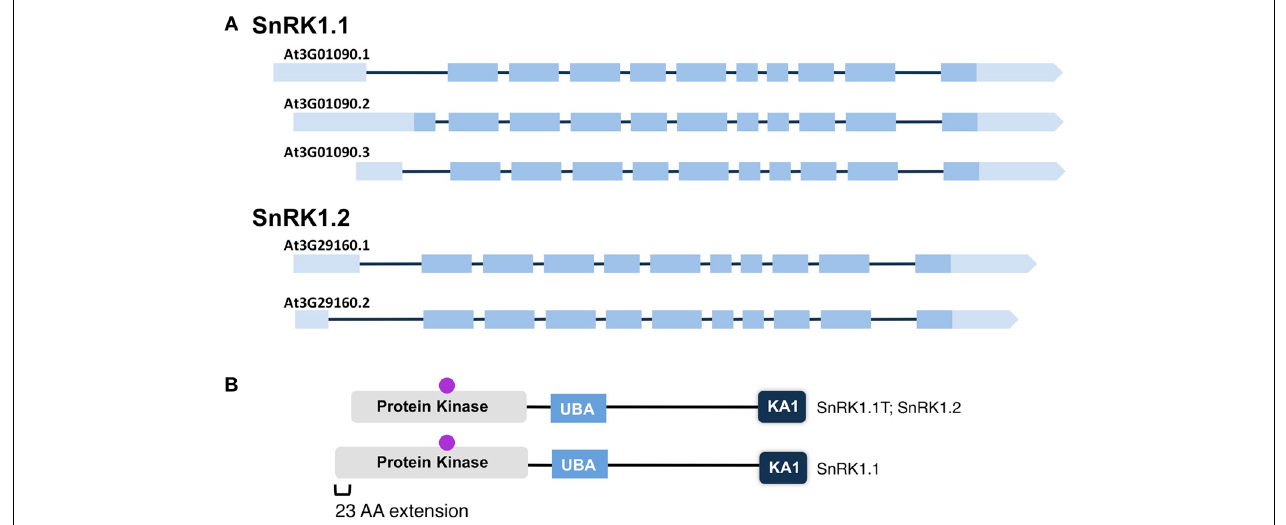
domains: Protein Kinase, Ubiquitin Associated (UBA), and Kinase Associated 1 (KA1). The location of the active site residues are indicated by a purple